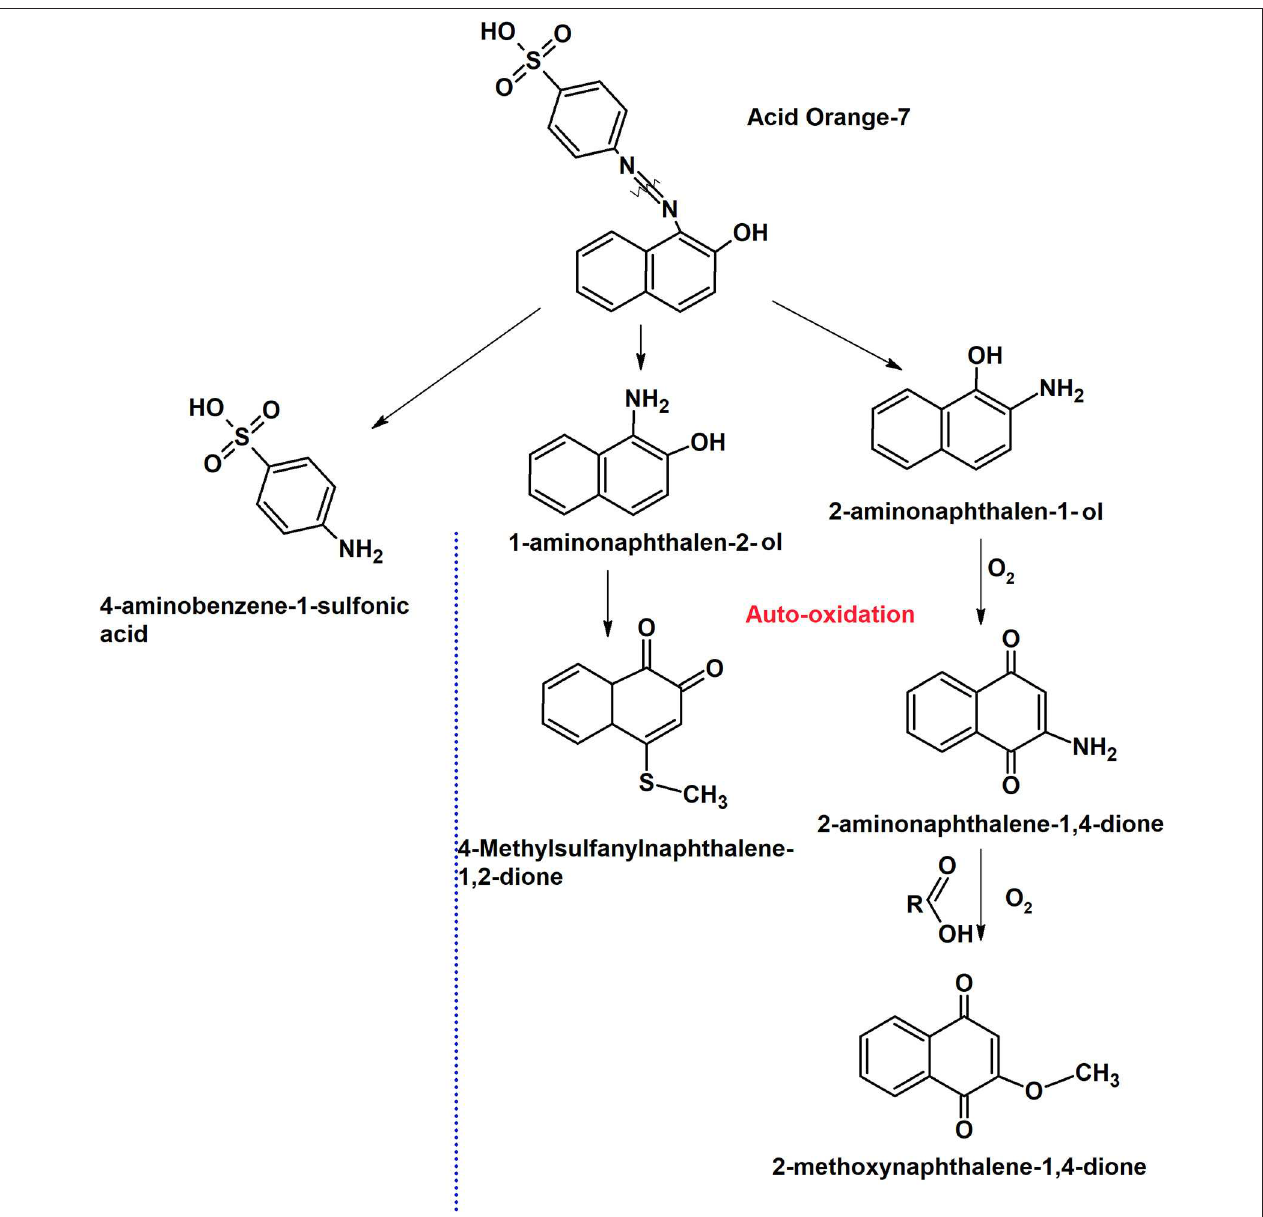
FIGURE 7 | Putative dye degradation pathway by S. oneidensis MR 1 at the anode and the auto-oxidation mechanism based on the intermediate products obtained from GC-MS analysis.